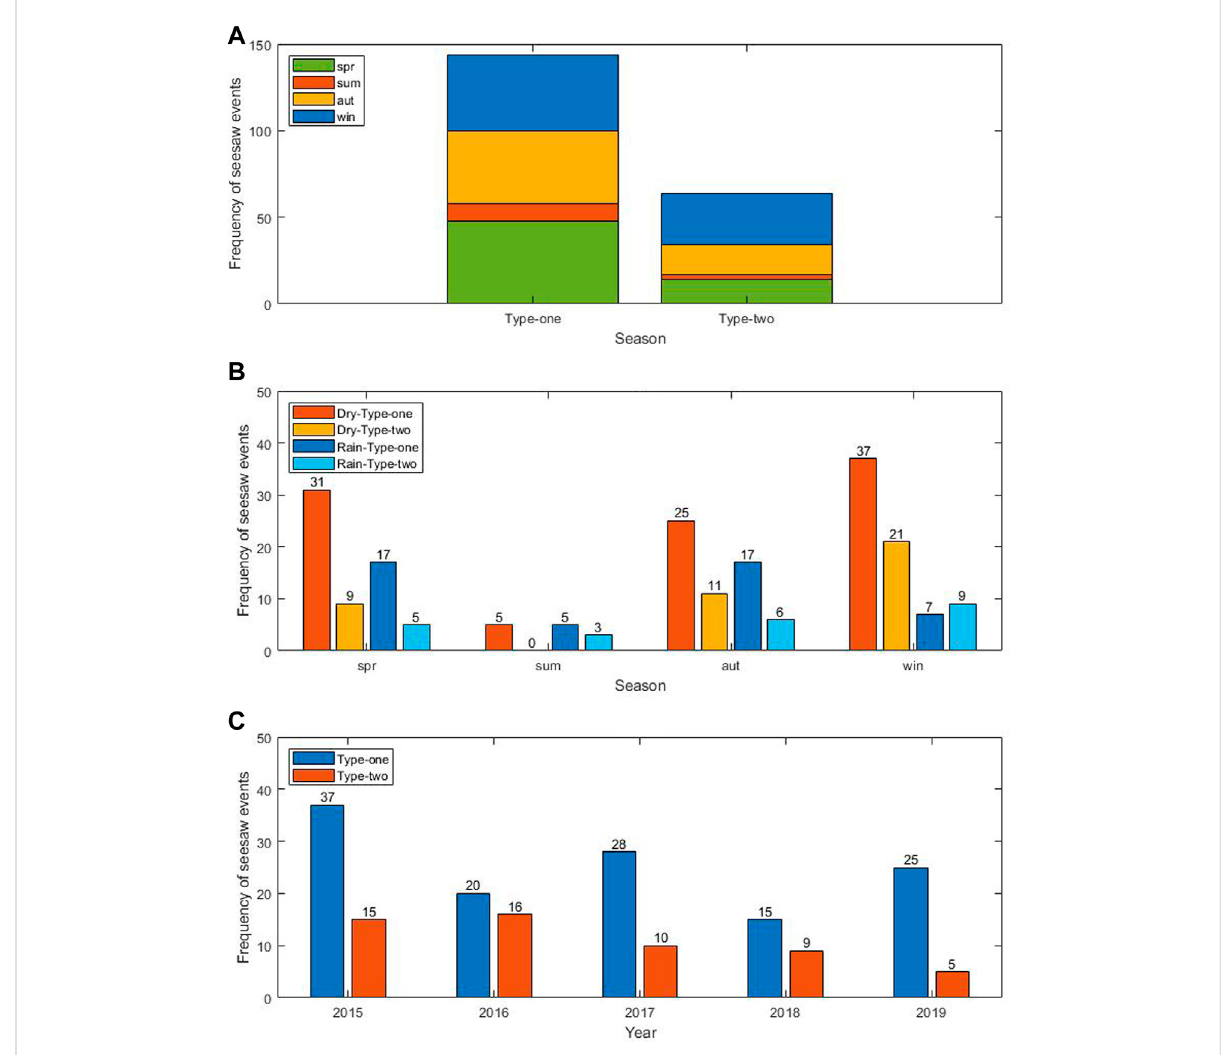
FIGURE 3 The seasonal distribution (A) , precipitation distribution (B) and annual distribution (C) of seesaw events in Shanghai during 2013 – 2020. If the hourly precipitation of any grid exceeds 0.5 mm, it is considered that there is an obvious wet cleaning process in this